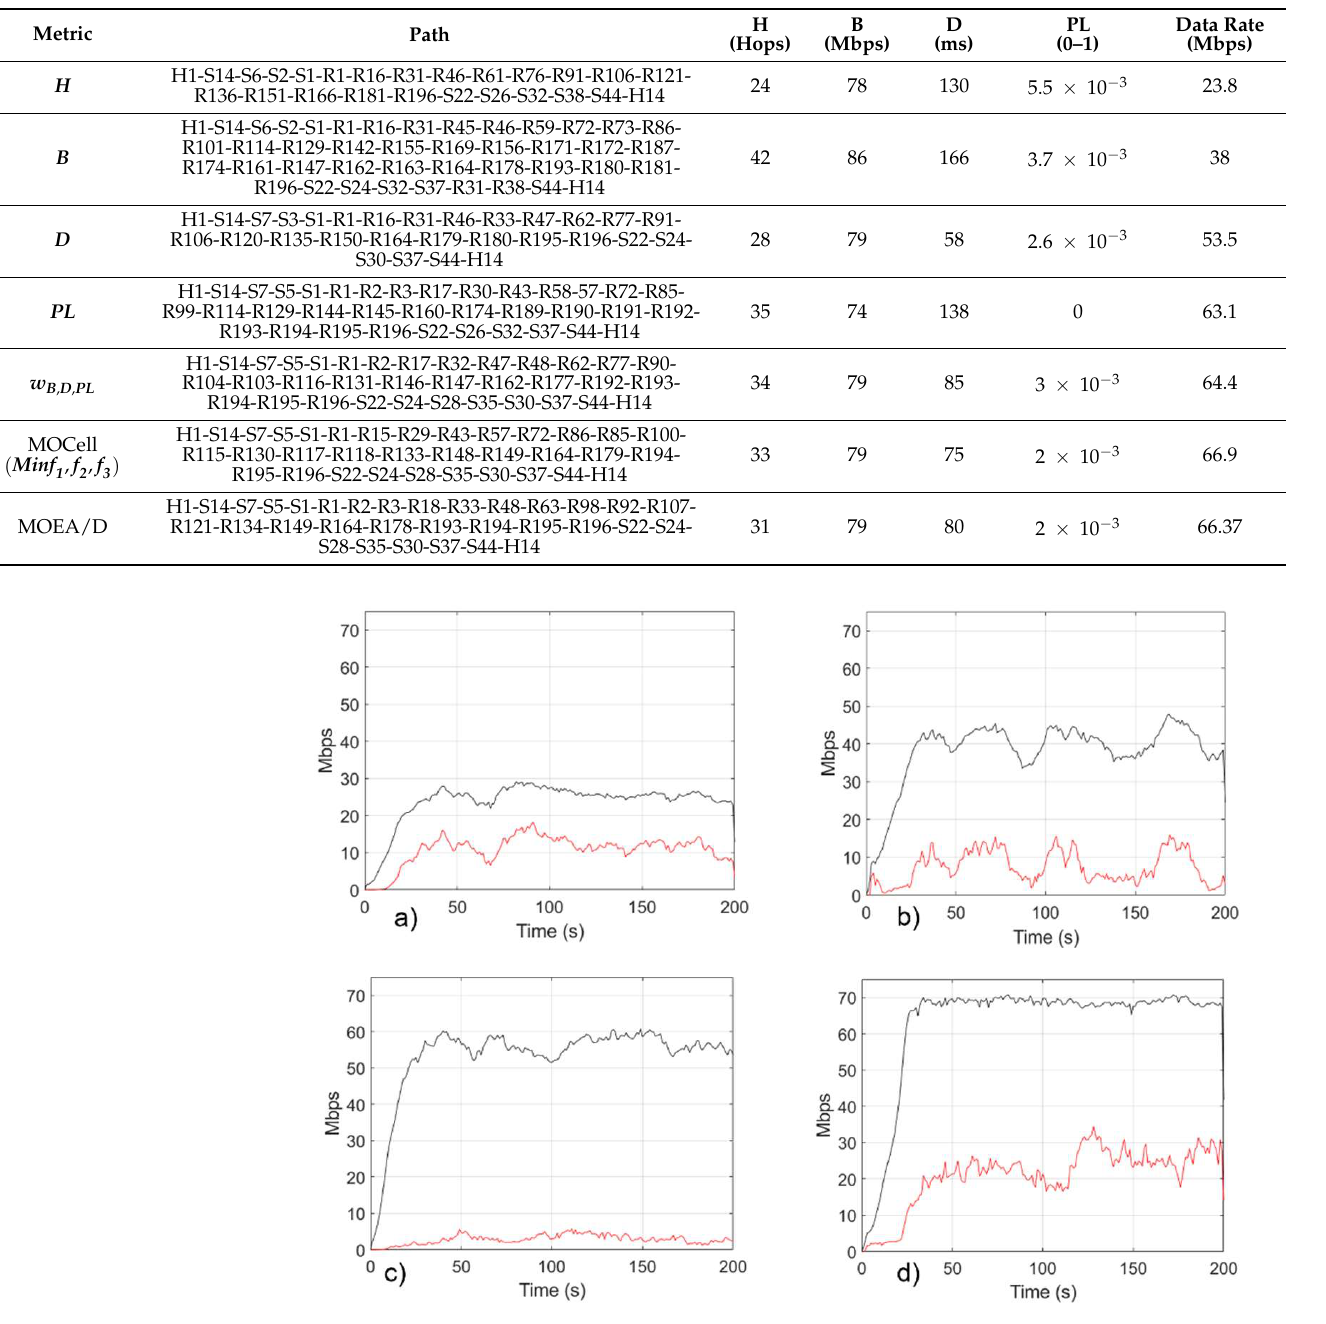
Table 4. Results of routing paths and network parameters.